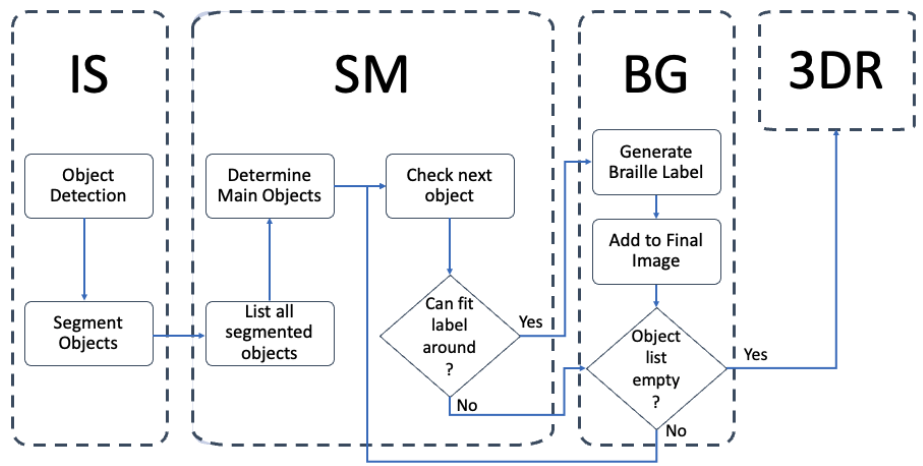
Figure 4. Flow of the instance segmentation with the integration of the selective